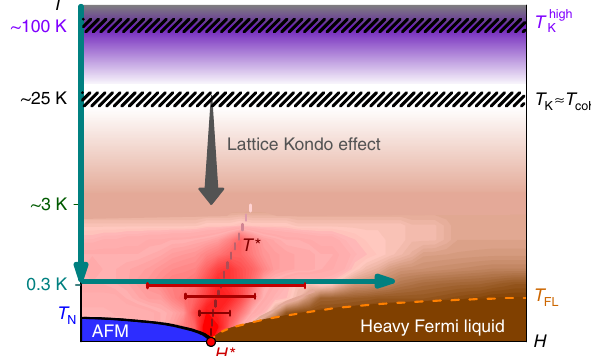
Fig. 1 Phase diagram of YbRh 2 Si 2 . Schematic temperature – magnetic fi eld phase diagram as inferred from magnetotransport 15,16 , magnetostriction 17 , and magnetization 20 measurements at low T , and STM measurements down to ~5K 7 . The QCP (red dot) is located at H * ≈ 0.06 T for H ⊥ c and H * ≈ 0.66 T for H jj c . The single-ion Kondo temperatures T high and T K involve K all (purple shading) and the lowest-lying (white) crystal electric fi eld levels, respectively. The lattice Kondo effect starts to develop around T coh ≈ T K . The Kondo-exchange interaction between the two types of spins, respectively, belonging to the local moments or the conduction electrons, gives rise to Kondo correlations in the spin-singlet channel, which are always dynamical at fi nite temperatures. The lattice Kondo effect (gray arrow) grows as temperature is decreased. At large magnetic fi elds, lowering the temperature eventually turns the short-lived lattice Kondo correlations into long-lived ones (brown region) indicating a heavy Fermi liquid with renormalized (large) Fermi surface well below T FL . For small magnetic fi elds the correlations stay dynamical. Here, an antiferromagnetic (AFM) order (blue region) develops below the Néel temperature T N , again with long-lived lattice Kondo correlations. The reddish regime embedding the T * ( H ) crossover line indicates incoherent quantum critical fl uctuations as the system evolves towards the respective ground state on either side 15 – 17 . This scale, anchored by the QCP, marks the fi nite-temperature signature of the Mott-type phase transition at T = 0, additionally visualized by the red bars corresponding to the width of the crossover in Hall effect 16 . The green arrows indicate the parameters used in STS